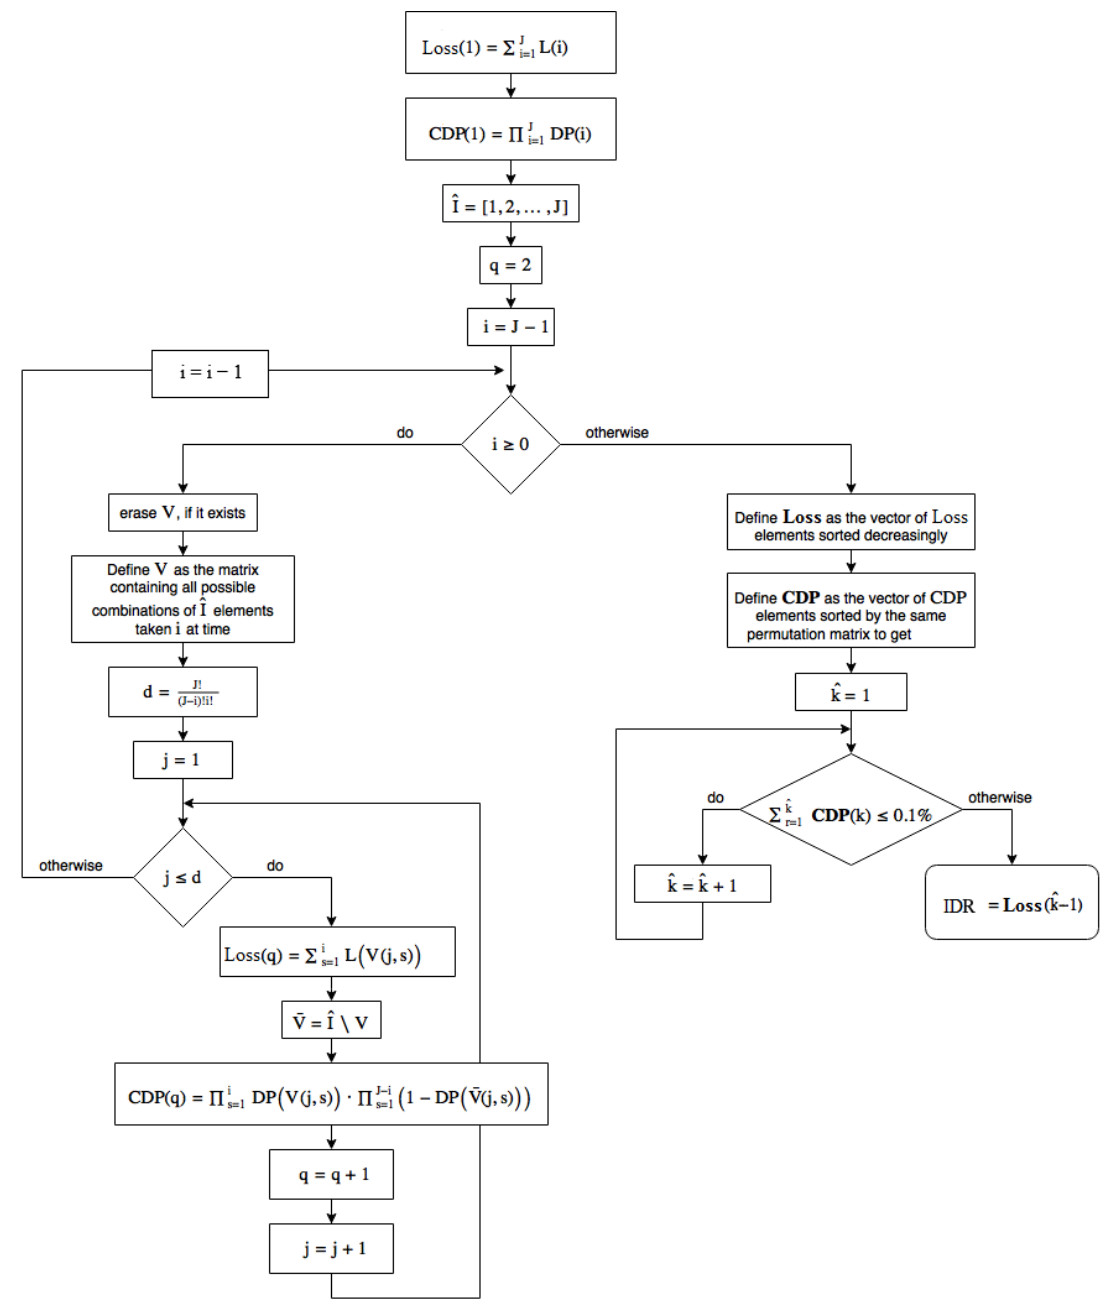
Figure 5: Evaluation procedure for the DRC, that corresponds the Loss P in to the 99.9% worst cases. For the sake of clarity, let us divide the graph in three main parts: before the i ≥ 0 -cycle , during and after the cycle